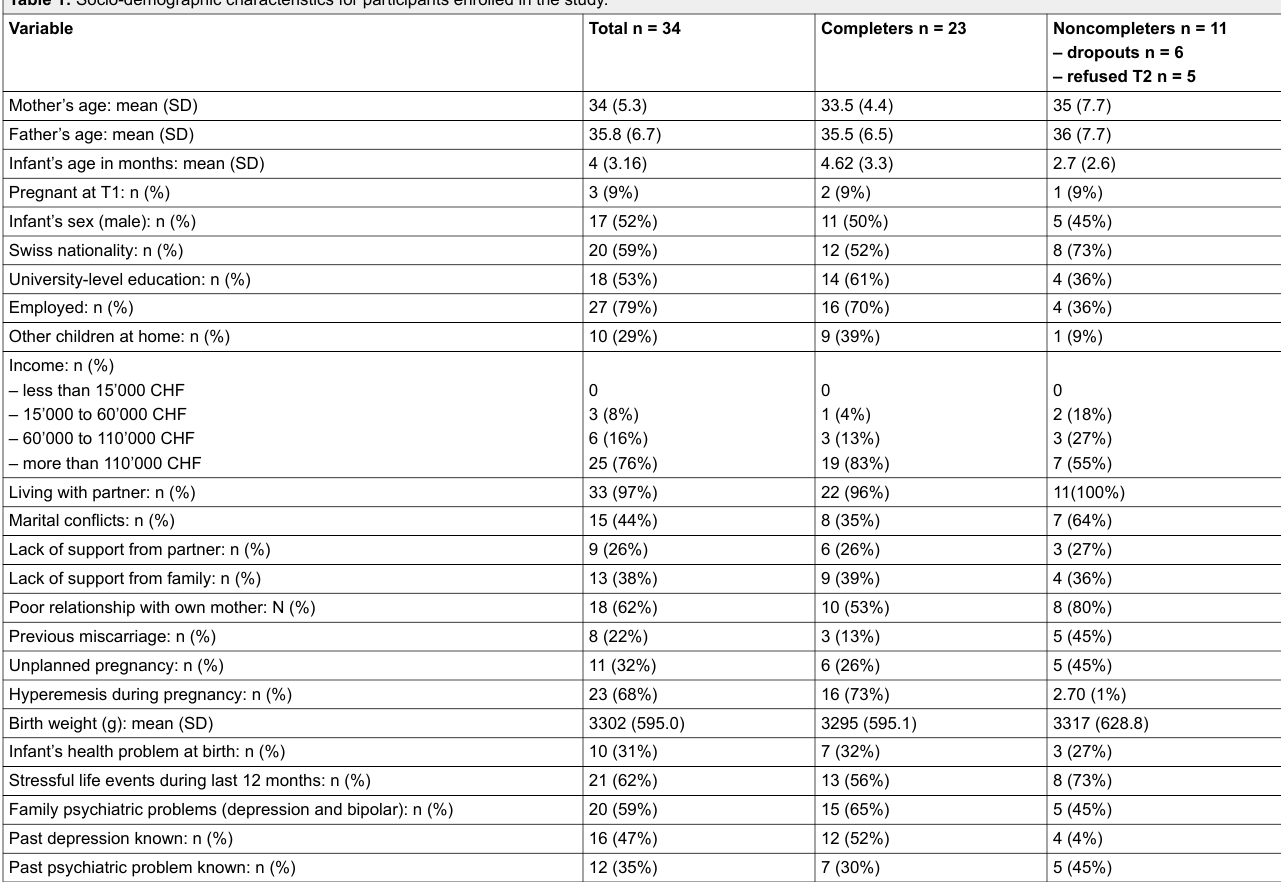
Table 1: Socio-demographic characteristics for participants enrolled in the study.